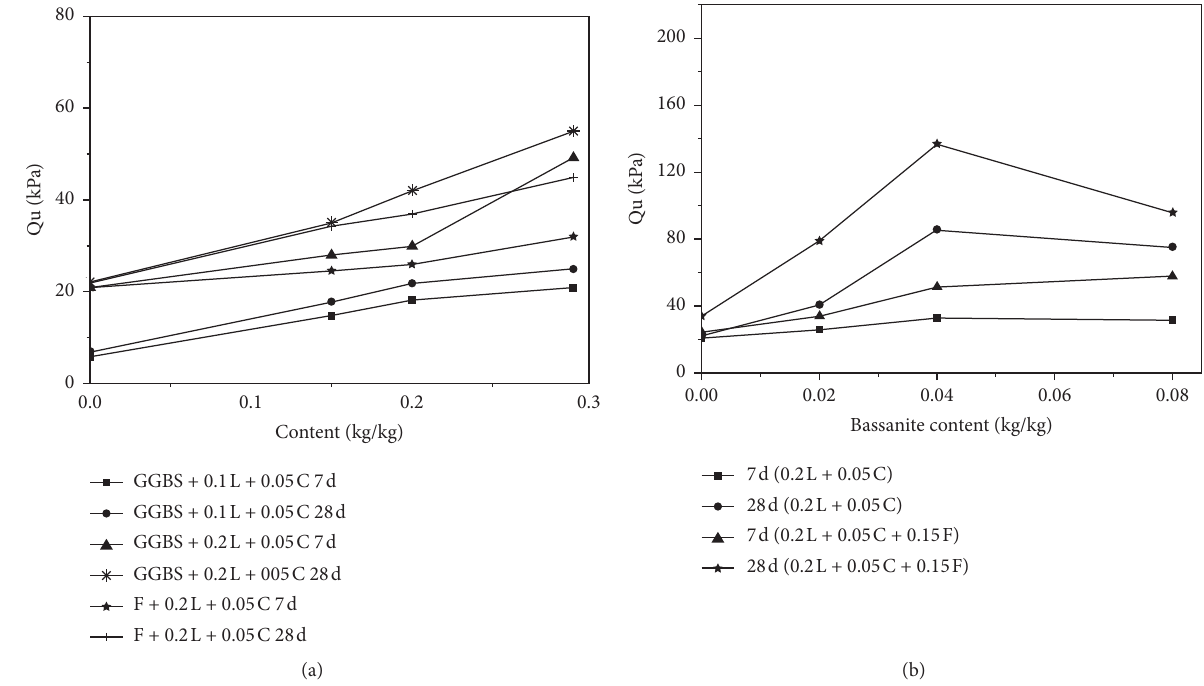
Figure 3: Specimen strength versus content of auxiliary additive. (a) GGBS and fly ash. (b) Gypsum (bassanite) (B).